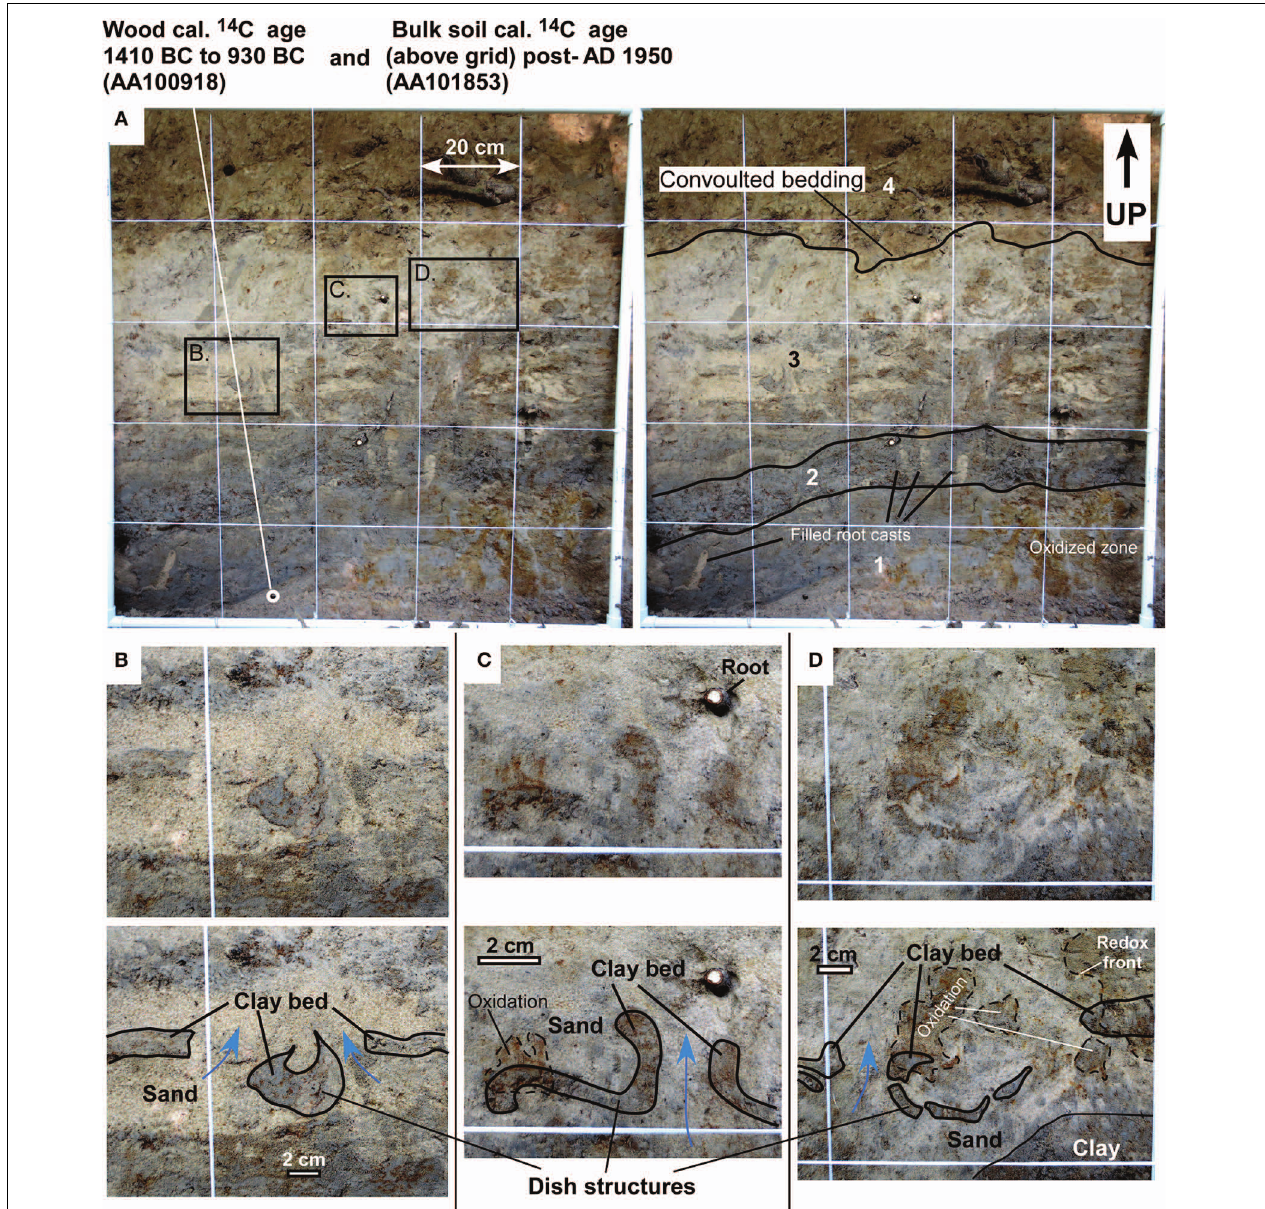
FIGURE 7 | SiteM (Wolf Creek, 33.53046 ◦ N, 91.7156 ◦ W)—Top is up. Locations of (B–D) are shown on (A) . (A) Uninterpreted photograph (left) and interpreted photograph (right) of 1 × 1m grid on vertical excavation showing small-scale bedding irregularities interpreted to be caused by ground shaking and liquefaction. Unit 1, Wolf Creek overbank, massive clay; Unit 2, Wolf Creek point-bar,medium-beddedsandyclay;Unit3,ConvolutedWolfCreekpoint-bar, medium interbeds of fine sand and clay; Unit 4, Wolf Creek overbank, massive loam (aggraded A soil horizon). We interpret the detrital wood 14 C age from Sample AA100918 to pre-date liquefaction, and thus it places a maximum age